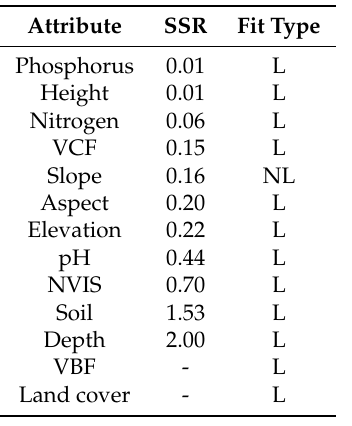
Table 2. Independent predictor attribute importance as determined by a measure of the Sum of Squared Residuals (SSR). Note, residuals are expressed as a percentage form the true value. The fit type ‘L’ represents a linear fit, whereas ‘NL’ represents a non-linear fit, as determined from the Harvey-Collier (HC)